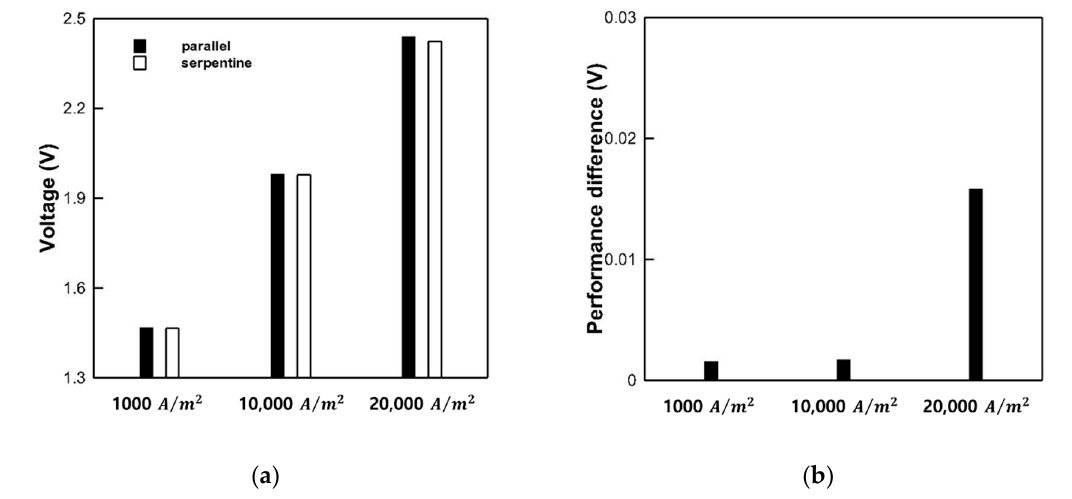
Figure 8. Performance of parallel and serpentine flow fields at 1000, 10,000, and 20,000 A/m 2 : ( a ) Operating voltage according to the current density and ( b ) performance difference according to the flow field.